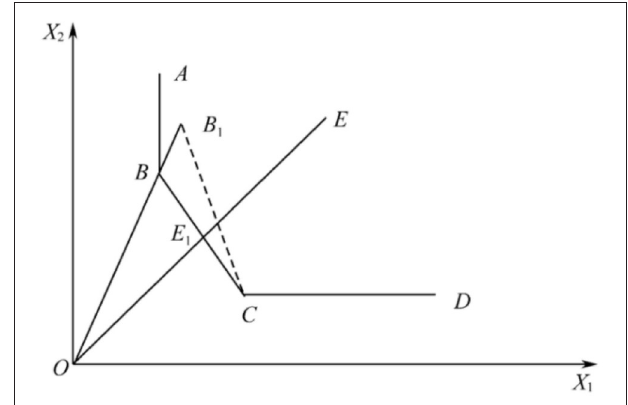
FIGURE 1 | Input-oriented super-efficiency data envelopment analysis